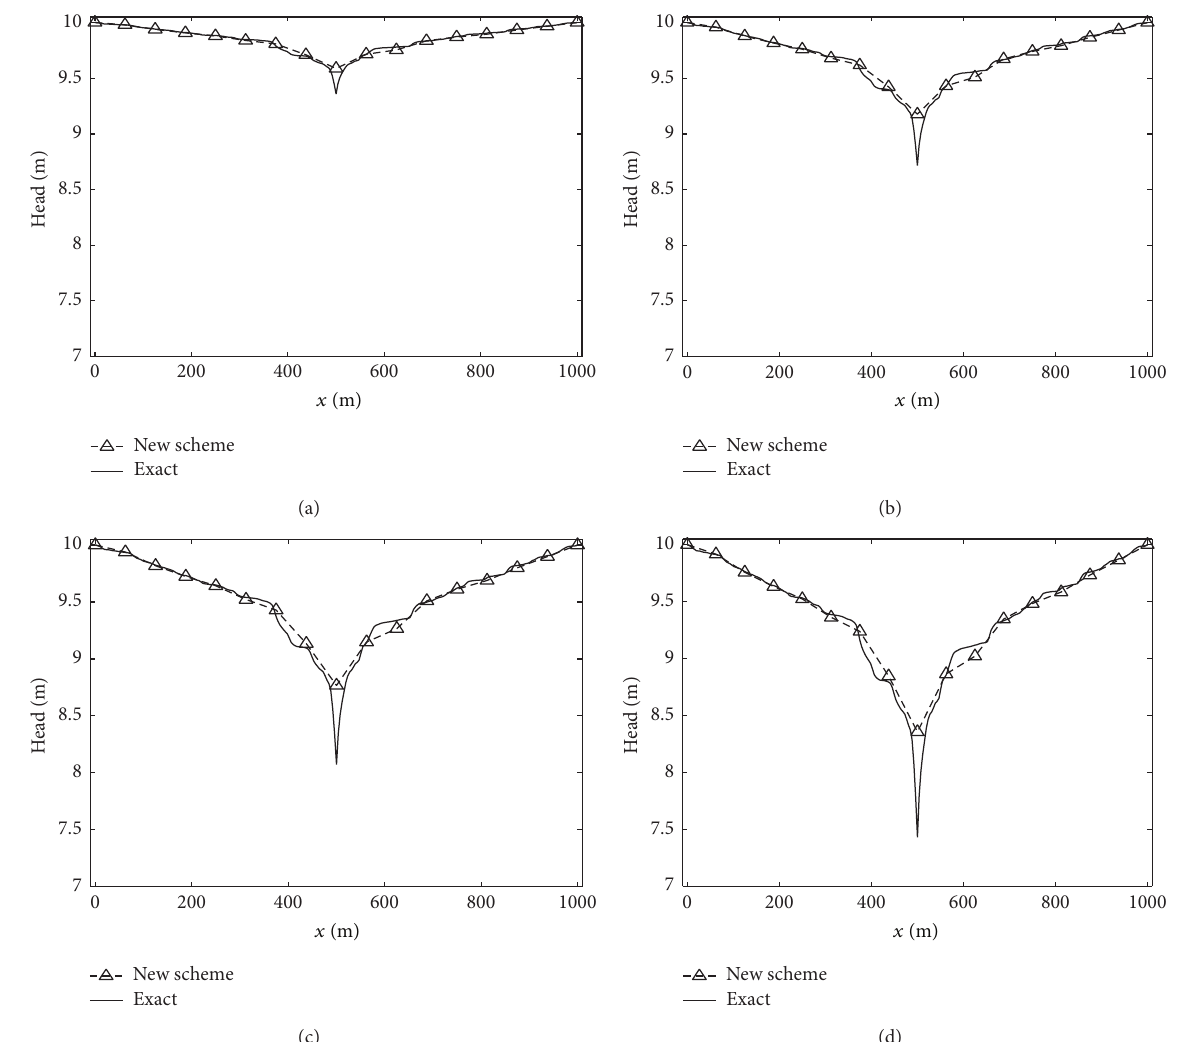
Figure 14: Exact solution and the coarse solution of the new scheme at the coarse 32 × 32 mesh in section 𝑦 = 500 m under different well flow rates: (a) 𝑄 = 0.12 , (b) 𝑄 = 0.24 , (c) 𝑄 = 0.36 , and (d) 𝑄 = 0.48 (m 3 (min) −1